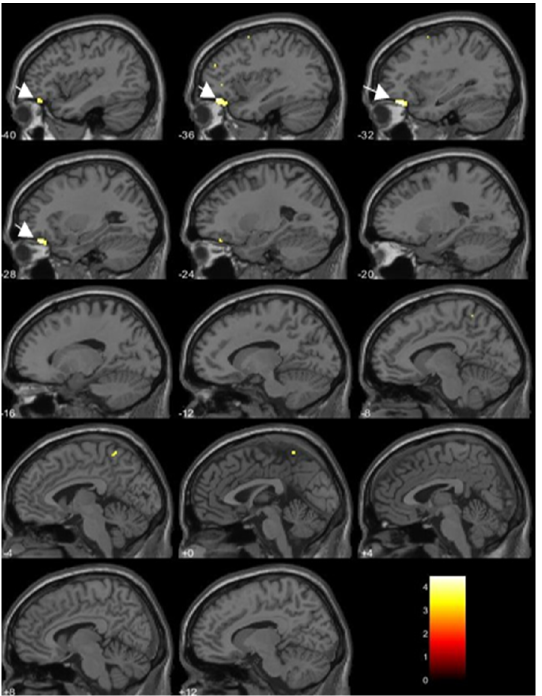
Figure 4. Brain regions associated with perinatal dioxin exposure (the left inferior frontal gyrus pars orbitalis indicated by yellow color and arrows on sagittal MRI slices). The volume was significantly lower in men with estimated perinatal dioxin exposure than in men without perinatal exposure (FDR ‐ corrected at p < 0.05). Each value below each brain slice indicates each value in MNI x ‐ coordinates.